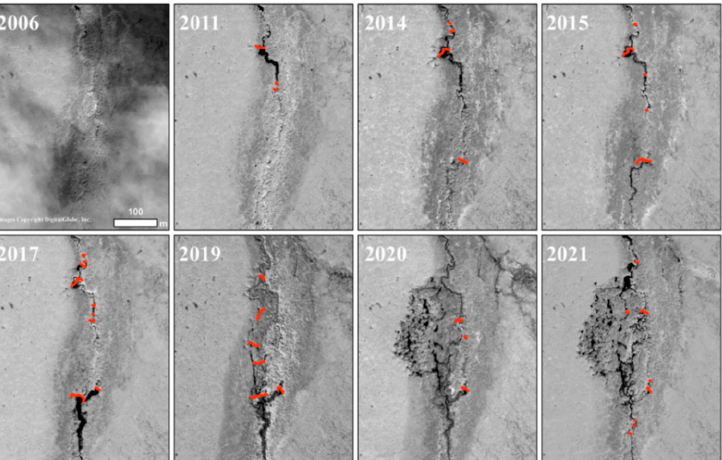
Figure 5. VHRS time series of imagery from the DigitalGlobe, Inc./MAXAR constellation of satellites showing the establishment of beavers in the Swan Lake Creek drainage after 2006. Dam building activity increased through 2017 when the main stream channel was routed to the northwest to- wards an ice-rich permafrost hillslope. The dam system ultimately failed between 2019 and 2020 and the catastrophic flood led to the development of a permafrost degradation feature formed by processes of fluvio-thermal erosion, thermal erosion, and subsequent thermokarst. Images are from 27 August 2006 (Quickbird-2), 27 July 2011 (Worldview-1), 5 August 2014 (GeoEye-1), 23 June 2015 (Worldview-1), 14 July 2017 (Worldview-2), 8 July 2019 (Worldview-1), 8 June 2020 (Worldview-2), and 5 August 2021 (Worldview-3). The red lines indicate the location of beaver dams in each image frame. All images are copyright DigitalGlobe,